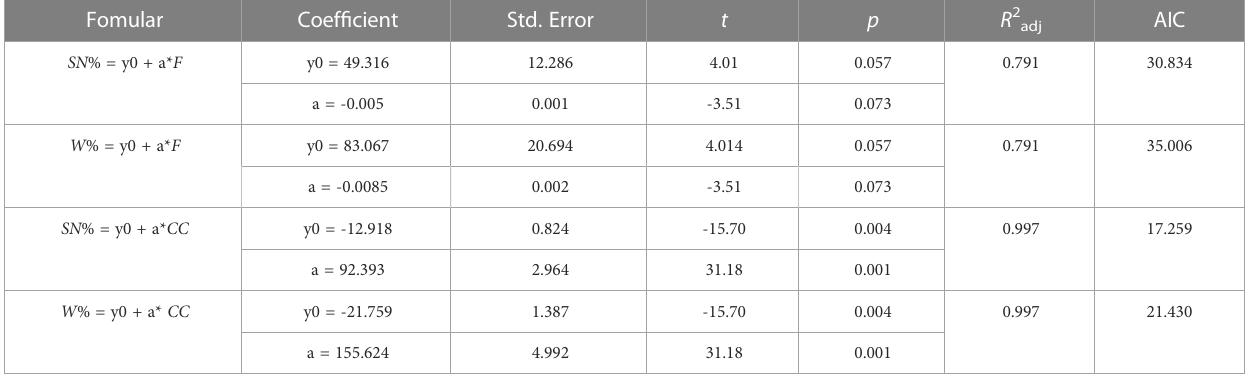
TABLE 4 Linear fi t parameters between percentages of species number ( SN ) and weight ( W ) of herbivorous fi shes by gillnet in the lagoon of in Meiji Reef and fi shing power ( F ) and coral cover ( CC ). Fomular Coef fi cient